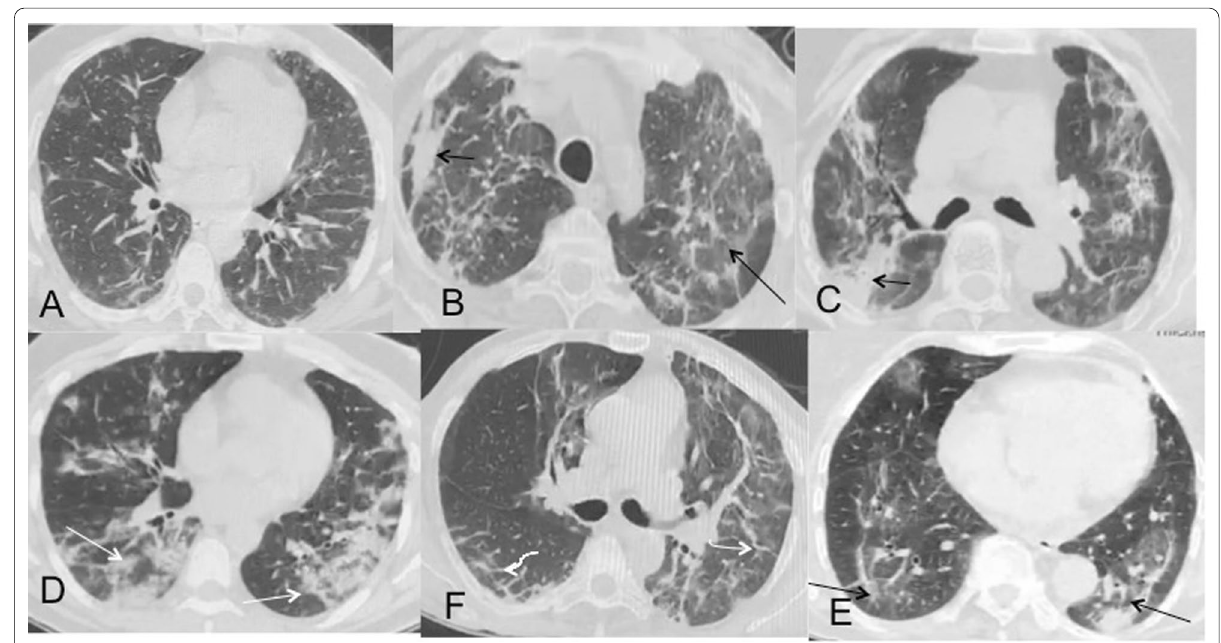
Fig. 3 Spectrum of HRCT changes in patients with reticular predominant post-COVID sequelae. a Mild reticular changes with just subpleural fibrotic stripes in posterior basal segments of bilateral lower lobes, b reticular opacities in both lungs with confluent fibrosis (black arrow) and atoll sign (long black arrow) , c reticular opacities with consolidations (black arrow), d reticulations with consolidations (white long arrows), e reticulations with bilateral interlobular septal thickening (curved arrows), f bilateral reversed halo (atoll) sign (long black arrows)